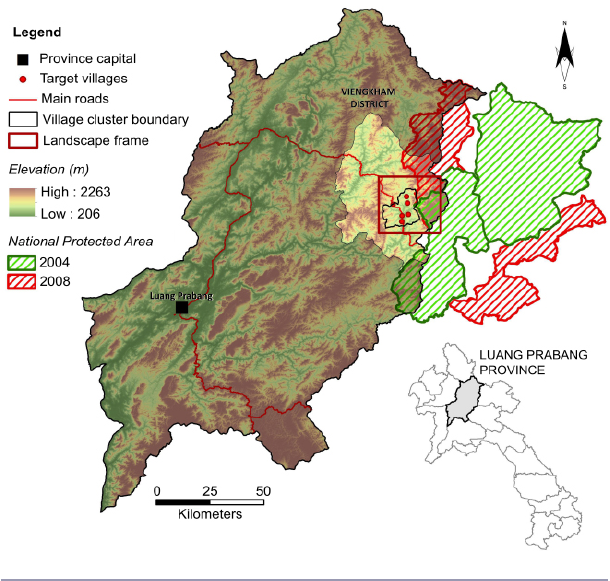
Fig. 1. Study area: village cluster of Muongmuay in Viengkham District, Luang Prabang Province,